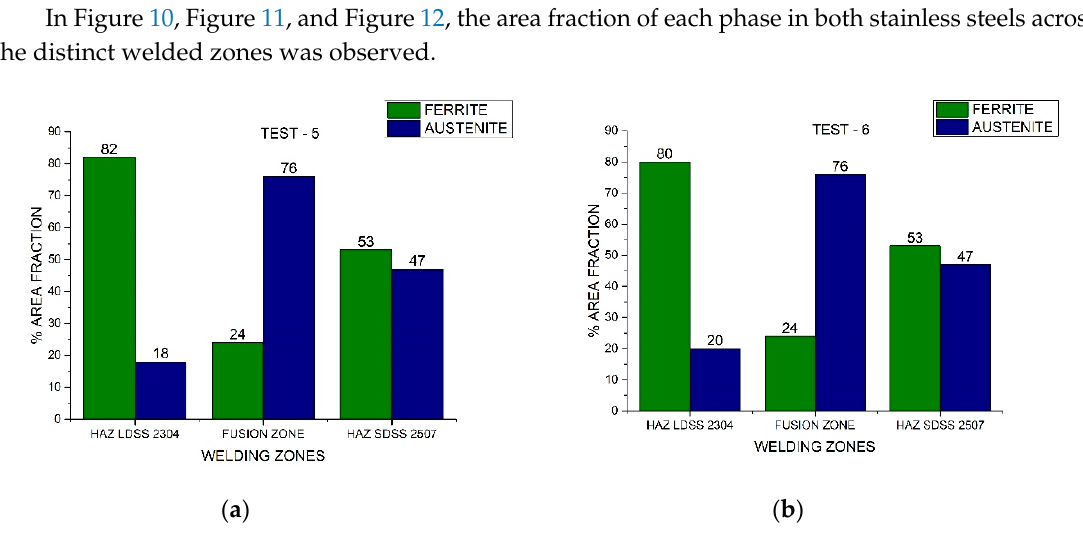
Figure 10. Area fraction through the distinct welded zones to 220 A: ( a ) Test #5 and ( b ) Test #6.